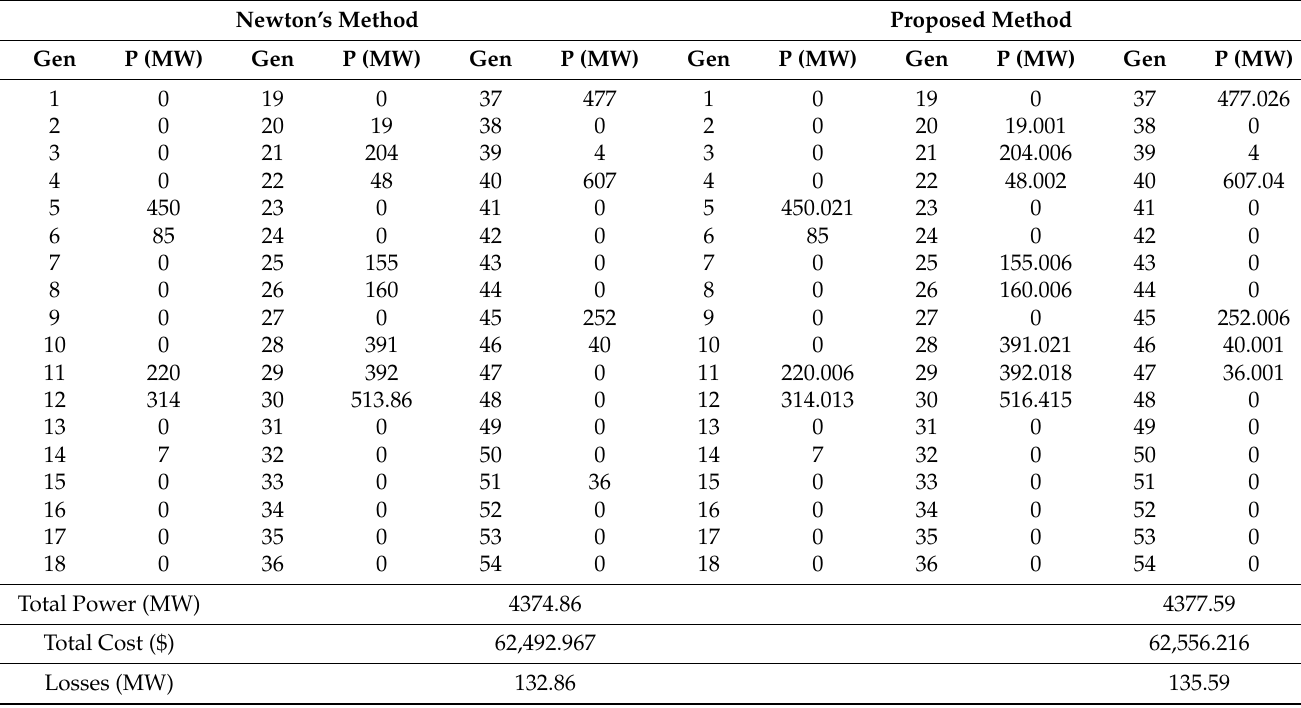
Table 8. The Comparison Results Between Newton and Proposed Methods.